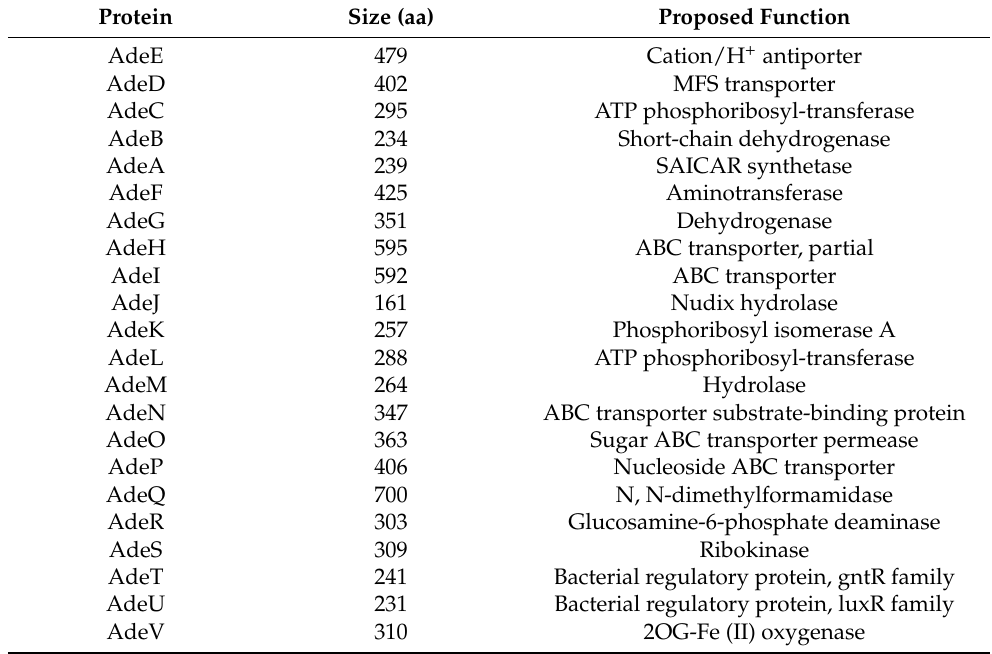
Table 3. The proposed functions of protein in the biosynthesis gene cluster of PNT, 2 (cid:48) -CLPNT, and 2 (cid:48) -amino-2 (cid:48) -deoxyadenosine in the Actinomadura sp. ATCC39365. Protein Size (aa) Proposed